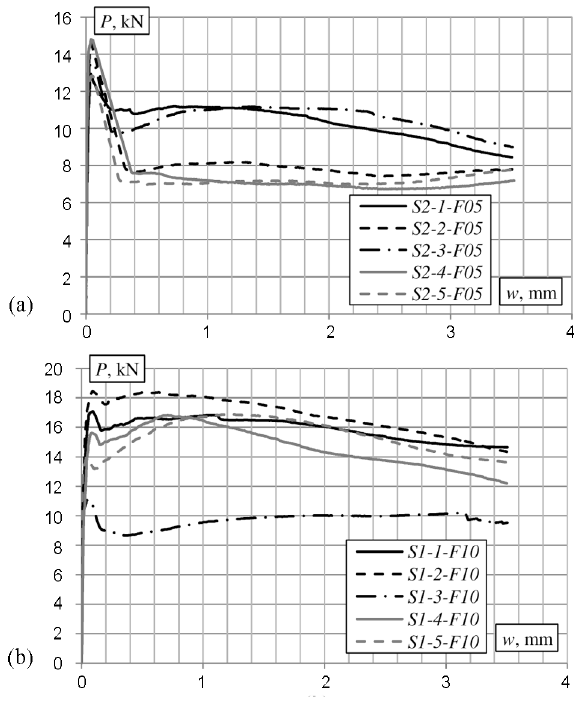
Fig. 7. Determined residual stress-crack width relationships for the test specimens with 0.5% (a) and 1.0% (b) fibre